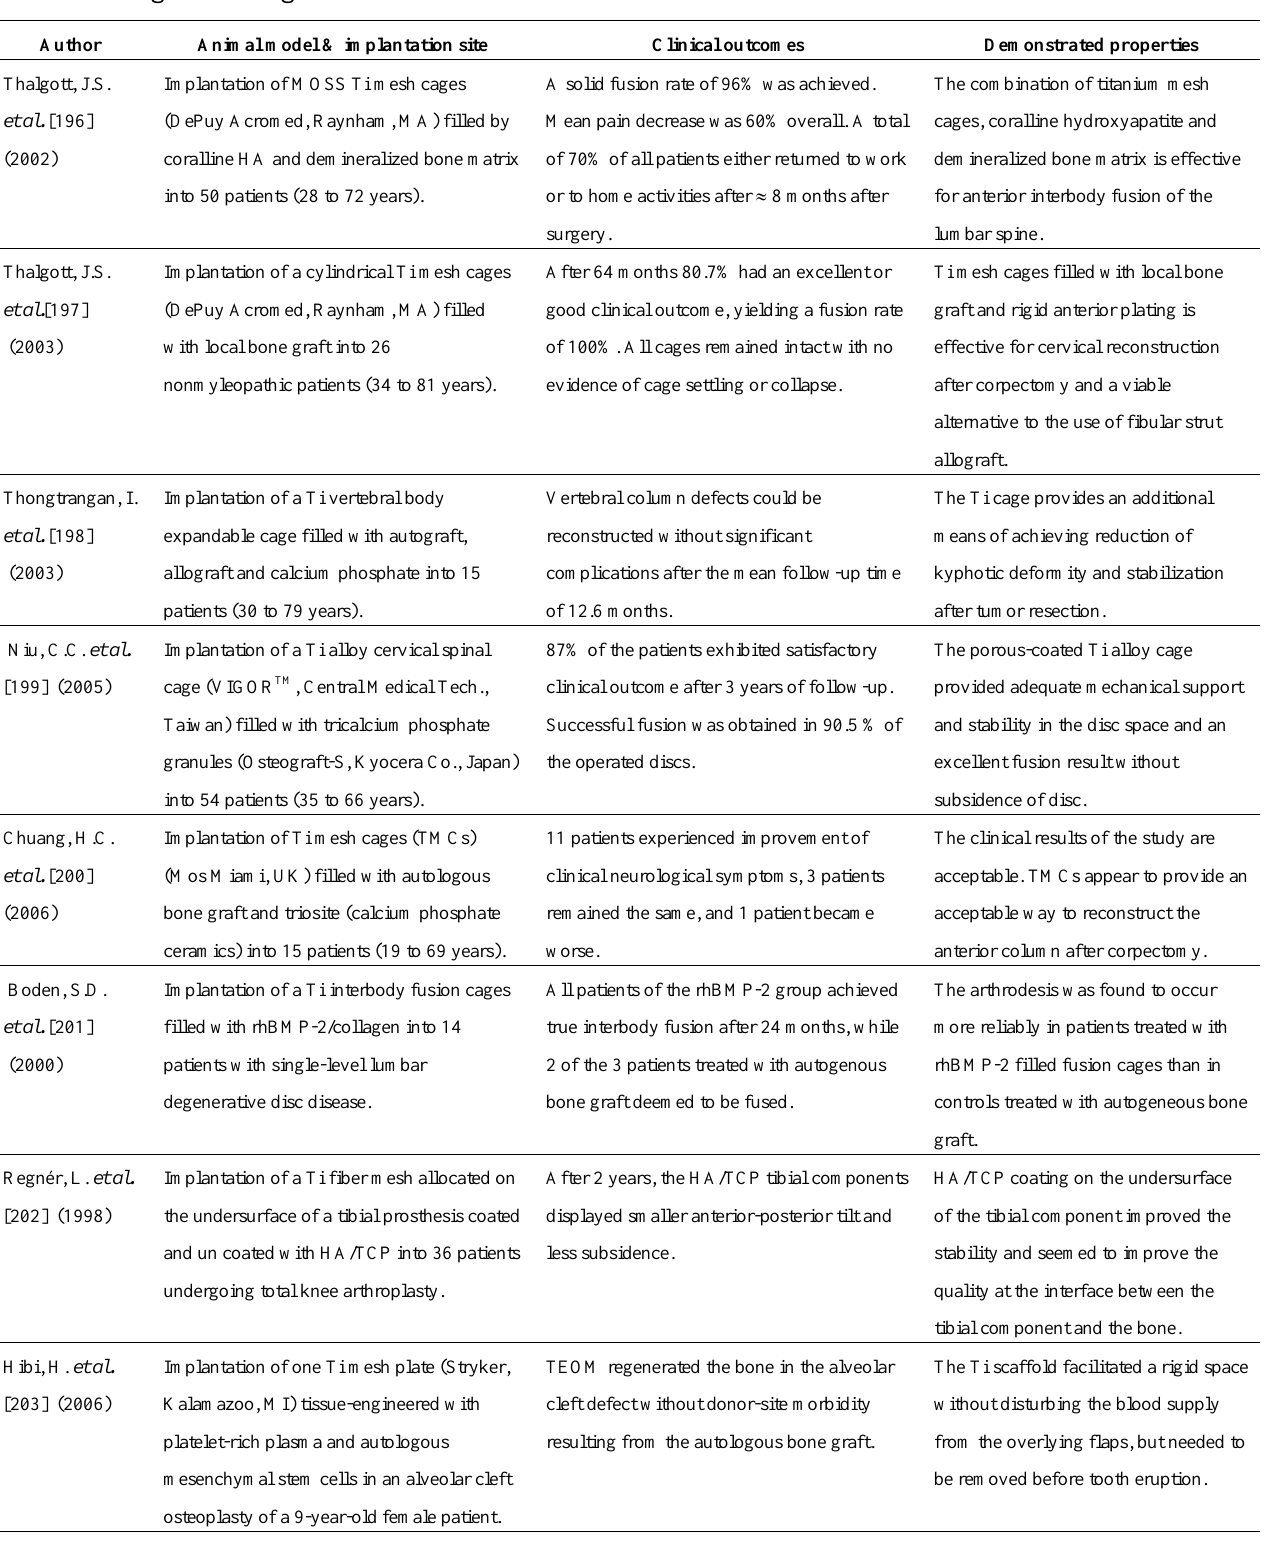
Table 15. Clinical studies using titanium-ceramic, titanium-polymer, or cell loaded or autologous bone graft loaded titanium